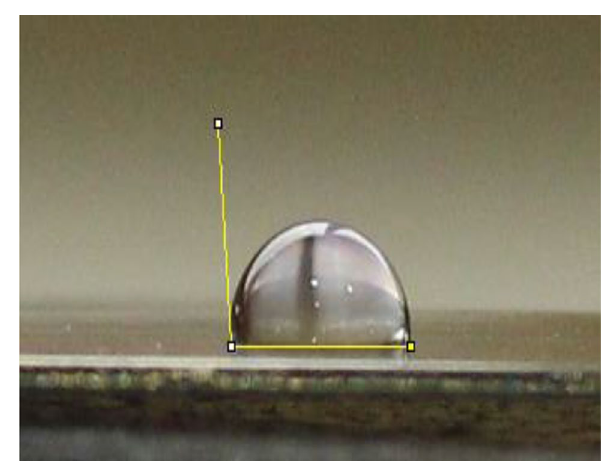
Fig. 6 Photograph of a water droplet placed on GO coated 304SS (θ =